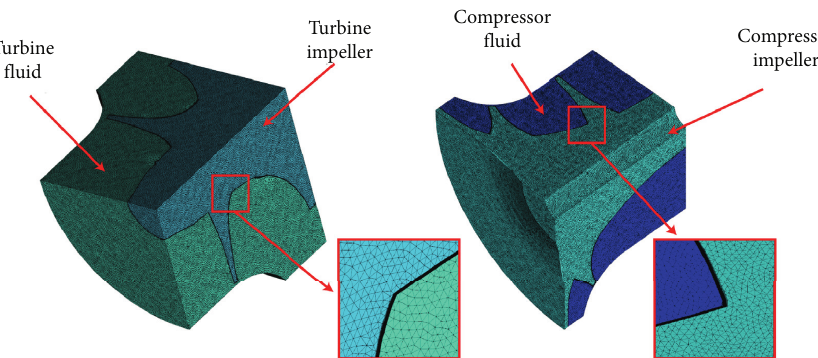
Figure 3: Computational grids for conjugate heat transfer calculation.